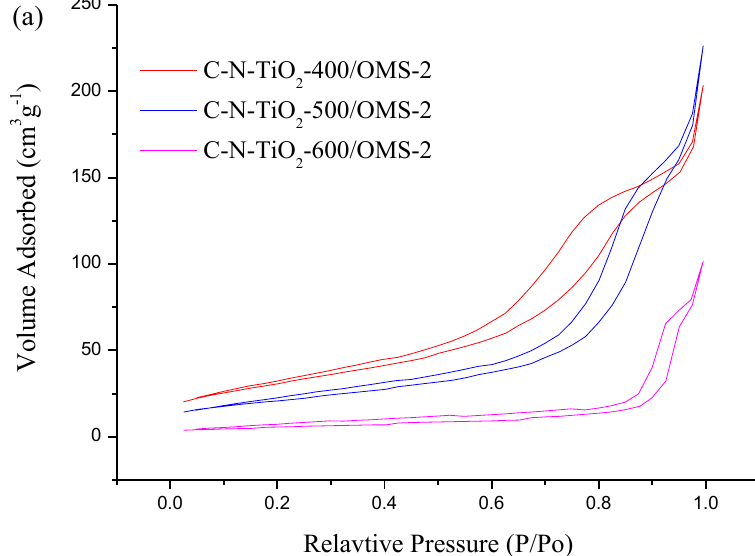
Figure 2. ( a ) Nitrogen adsorption-desoprtion isotherms and ( b ) pore size distribution of CN-TiO 2 /OMS-2 samples with different calcination